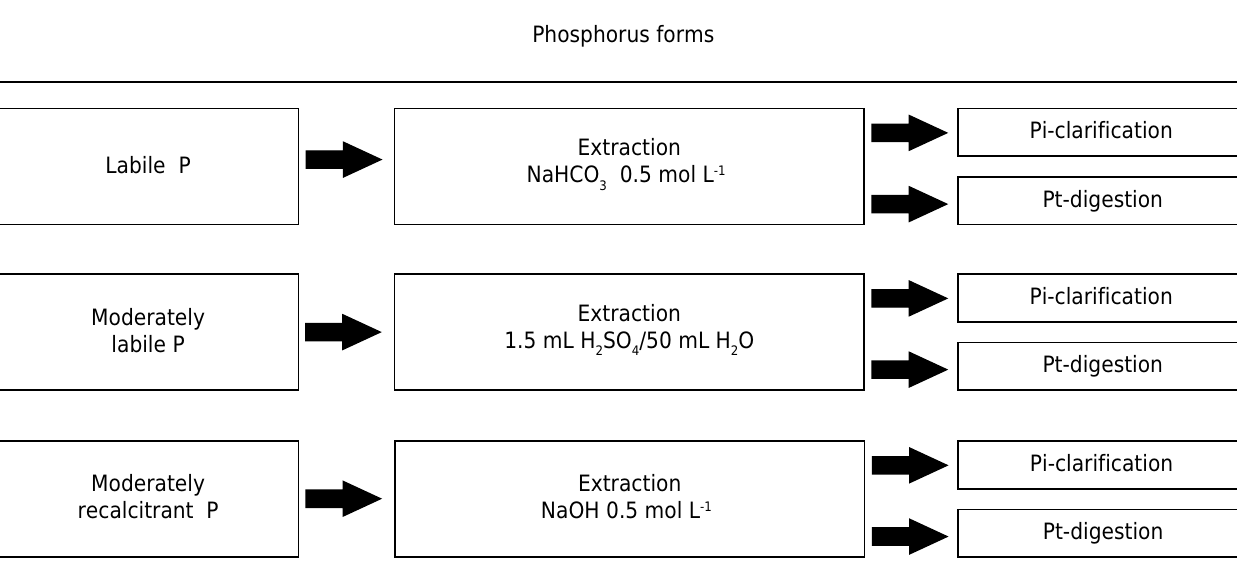
Figure 2. Schematic diagram of the sequential fractionation of soil organic phosphorus (Bowman and Cole, 1978a; Bowman, 1989).